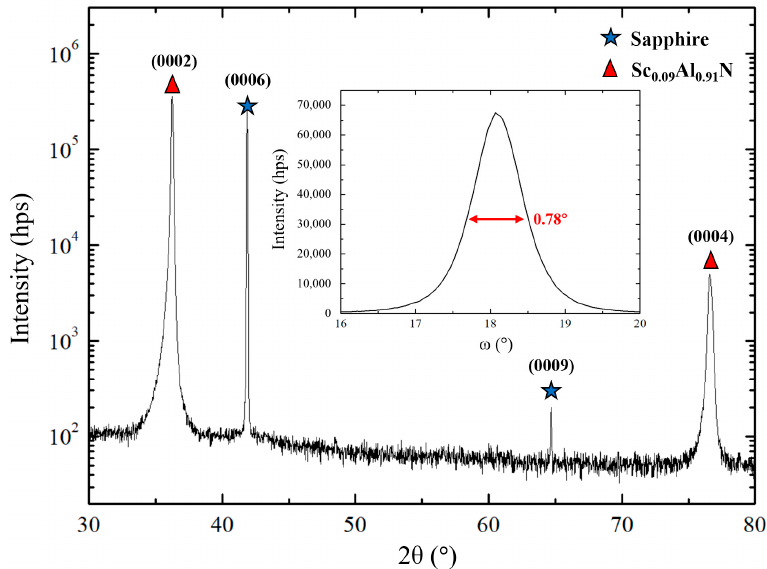
Figure 3. θ -2 θ diagram of a Sc 0.09 Al 0.91 N thin film deposited on a 650 °C heated sapphire substrate, with a plasma pressure of 7 mTorr. The inset figure shows the rocking-curve of the (0002) orientation.